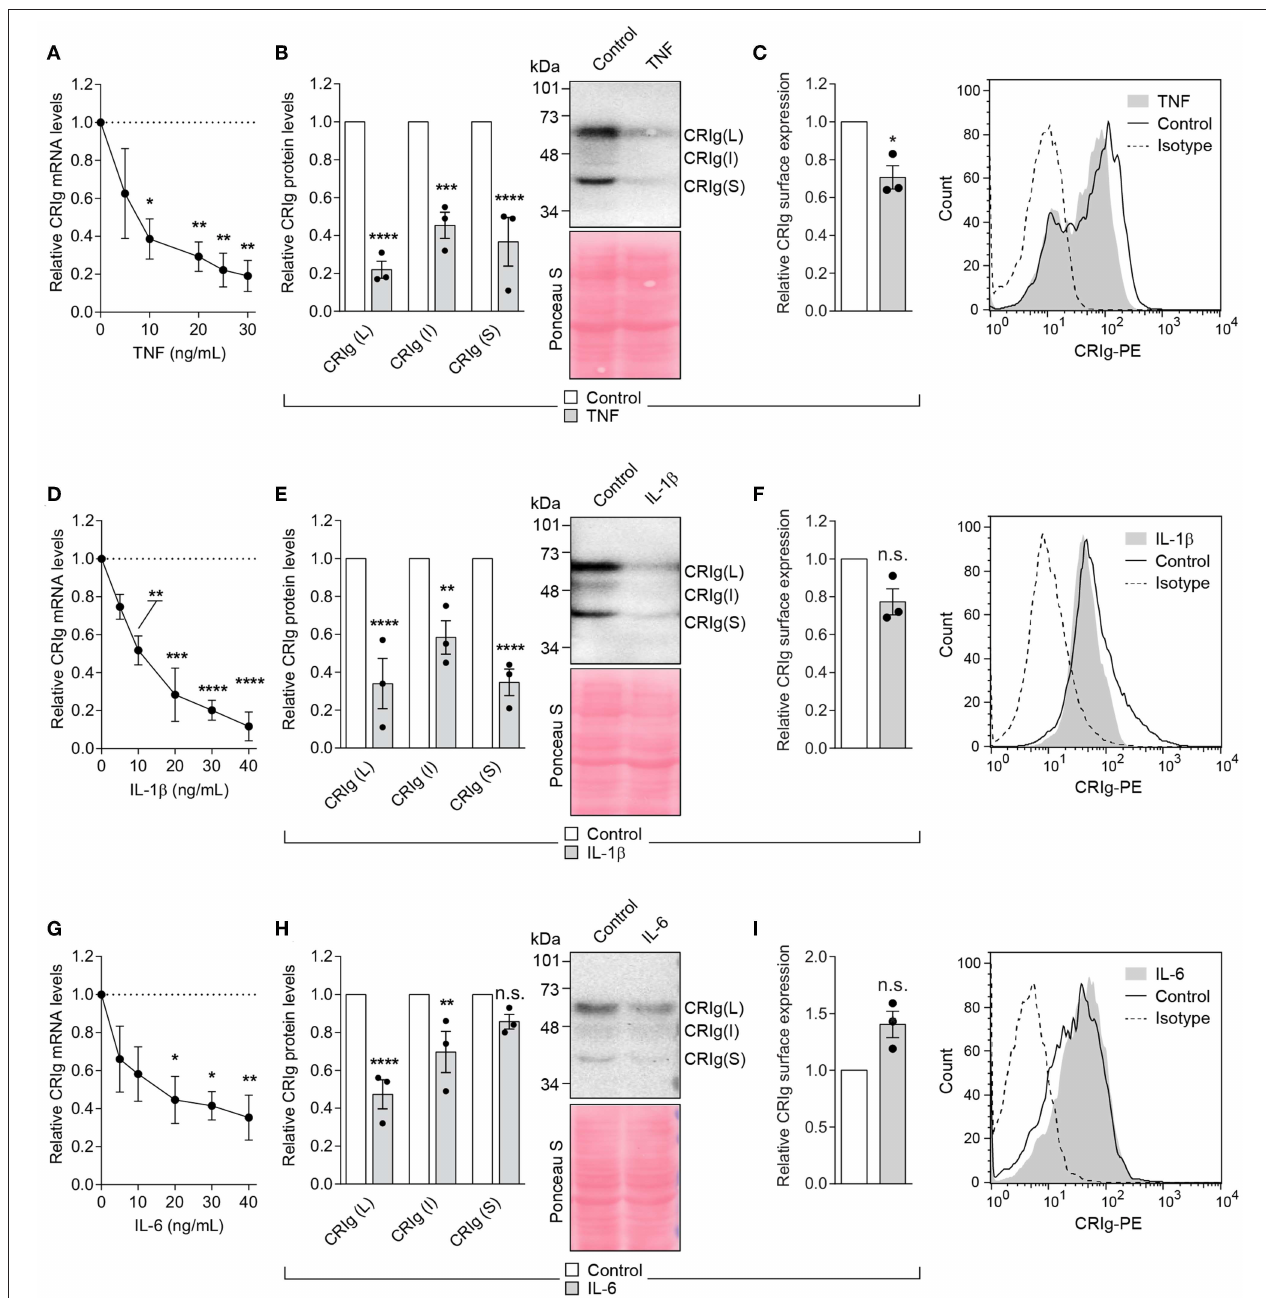
FIGURE 6 | Effect of TNF- α , IL-1 β , and IL-10 on CRIg expression in DC. (A,D,G) DC were treated with varying concentrations of the cytokines for 24h and then examined for CRIg mRNA expression. For examination of CRIg isoform protein expression (B,E,H) and cell surface expression (C,F,I) , the cells were treated with 40ng/ml of cytokine. Data are presented as means ± SEM of three experiments, each conducted with cells from different individuals. Significance levels are indicated by asterisks: * P < 0.05, ** P < 0.01, *** P < 0.001, **** P < 0.0001, whilst n.s. indicates non-significance.